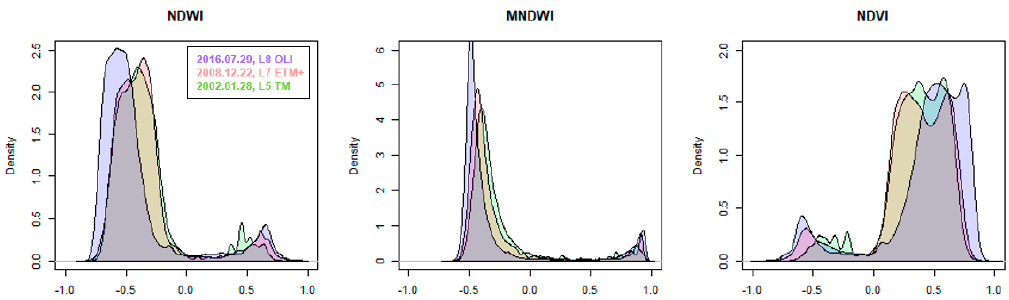
Figure 3. Illustration of bi-model histogram of pixel distribution from different water spectral indices in our study area.